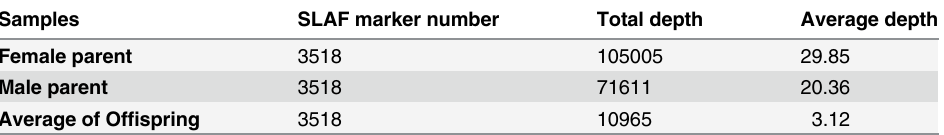
Table 3. Summary of effective SLAF markers depths.